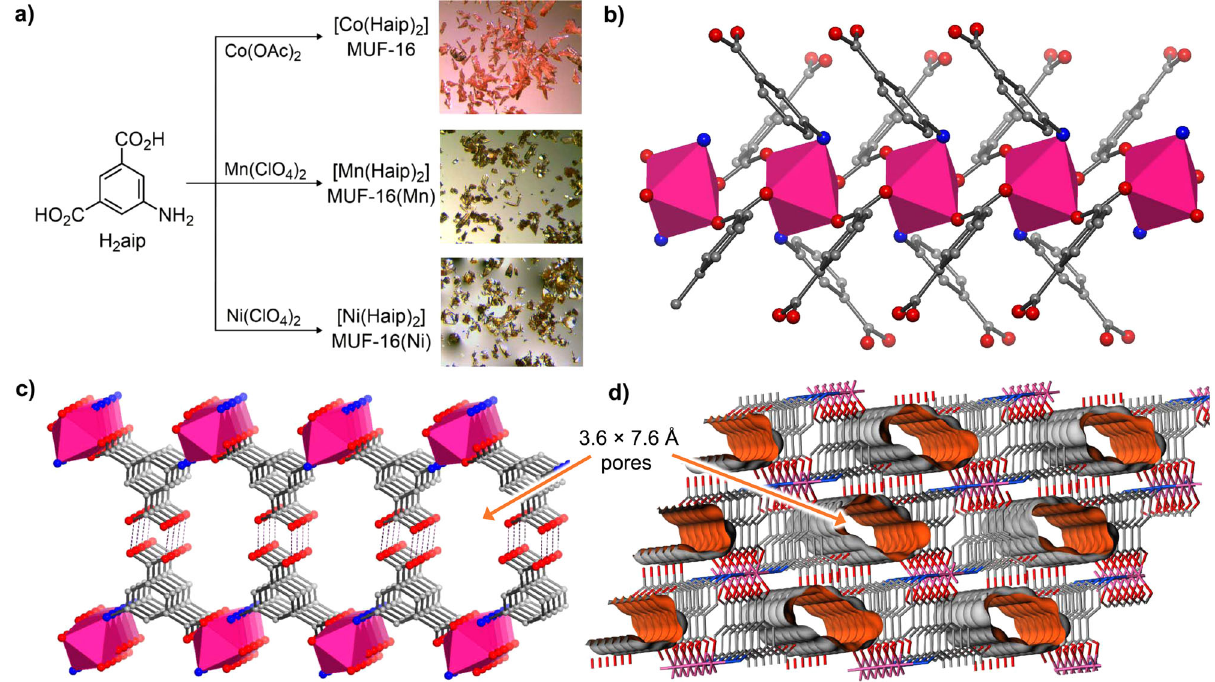
Fig. 1 Synthesis and structure of MUF-16 materials. a Synthetic routes to the MUF-16 family and optical micrographs of the reaction products. b In fi nite secondary building units (iSBUs) in MUF-16 comprise one-dimensional cobalt(II) chains connected by μ 2 -bridging carboxylate groups of the Haip ligands (H 2 aip = 5-aminoisophthalic acid). The cobalt(II) ions are depicted as fi lled octahedra. c The iSBUs are linked into planar two-dimensional sheets by the Haip ligands and further connected into a three-dimensional framework by hydrogen bonding (depicted as dashed lines) between adjacent sheets. d MUF- 16 features one-dimensional channels with approximate dimensions of 3.6 × 7.6 Å that propagate through the framework. The Connolly surface of the framework is shown in orange and de fi ned with a probe of diameter 1.0 Å. Colour code: Co = magenta; O = red; C = grey, N = blue.